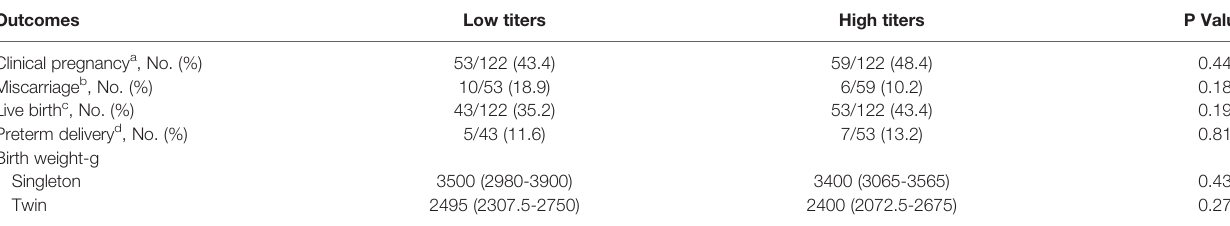
TABLE 7 | Subgroup analysis for pregnancy outcomes according to isolated TGAb tertiles.